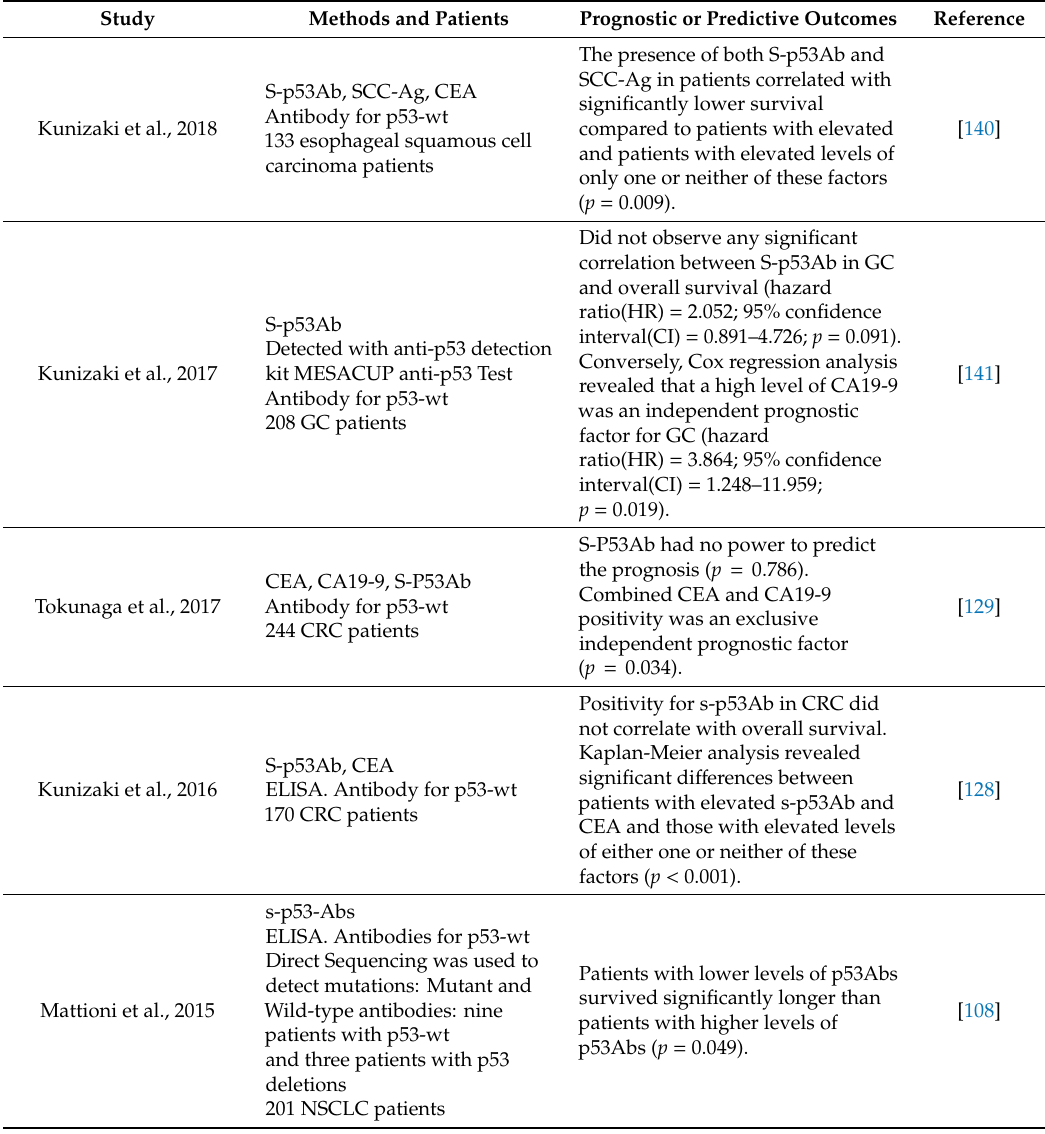
Table 1. Clinical studies investigating the prognostic value of serum p53 antibodies (s-p53-Abs) in